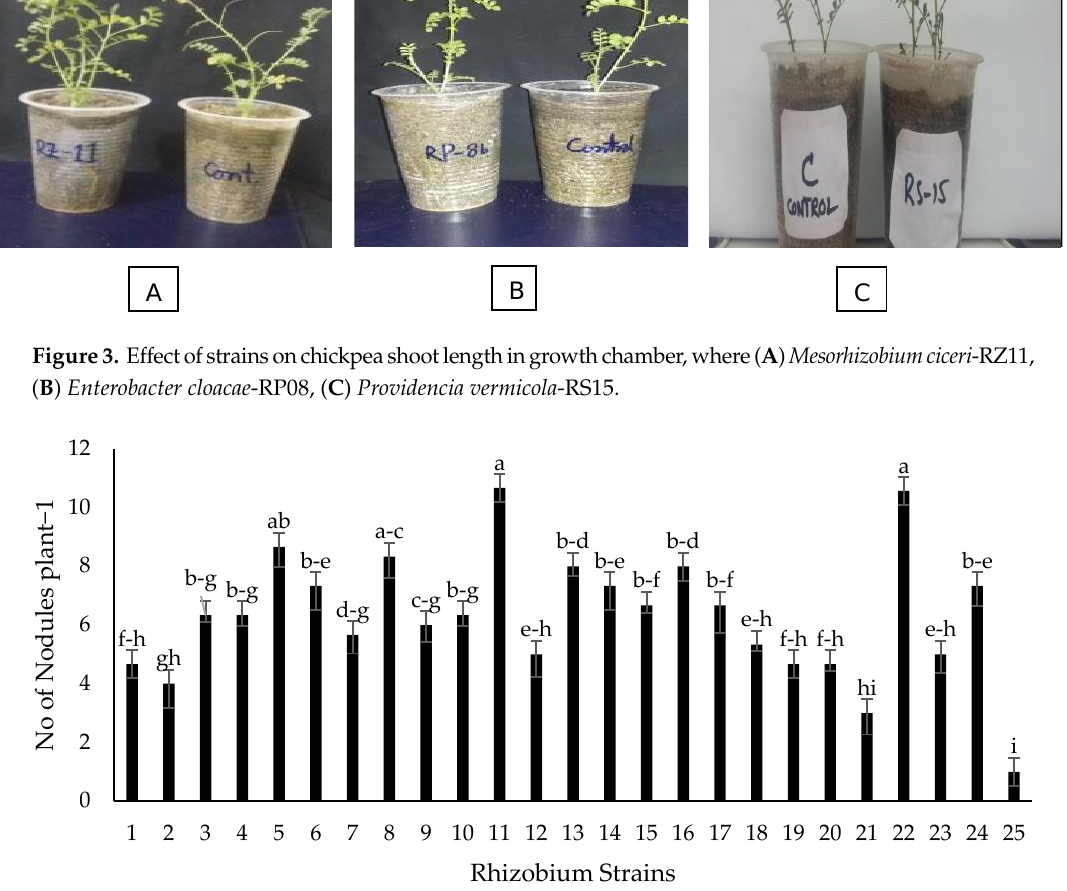
Figure 4. E ff ect of Rhizobium strains on nodulation plant − 1 . Strains (1–24) are rhizobium (RZ-01 to